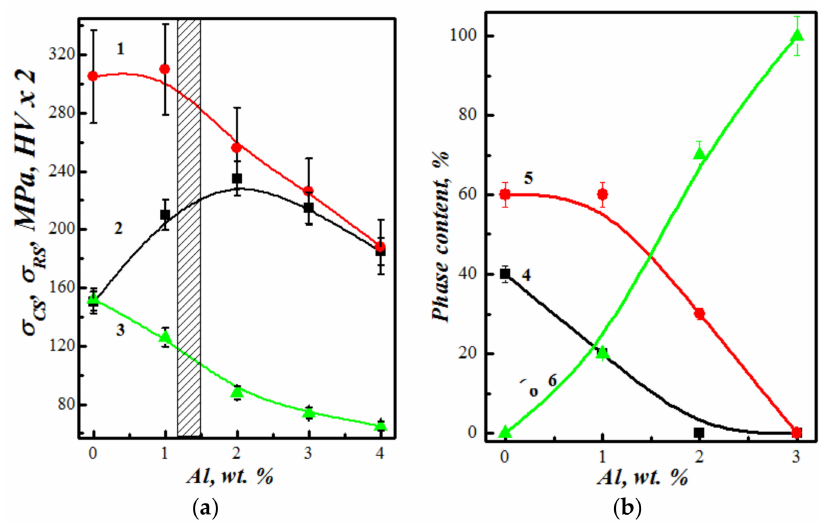
Figure 9. Mechanical properties: ( a ) Hardness HV (1), cohesive strength σ CS (2) and residual stresses σ RS (3) and ( b ) relative amounts of martensite (4), residual austenite (5), and ferrite (6) in coatings versus aluminum content Al in ASCs deposited by spraying of CW C1.4Cr14 Al(0 . . . 4). Hatching highlights the zone of optimal aluminum content in the coating to provide the best combination of the analyzed